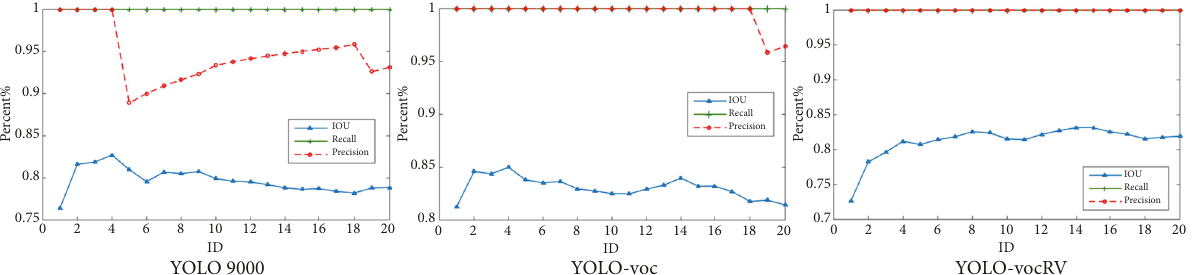
Figure 10: Test results of different models under free flow conditions.